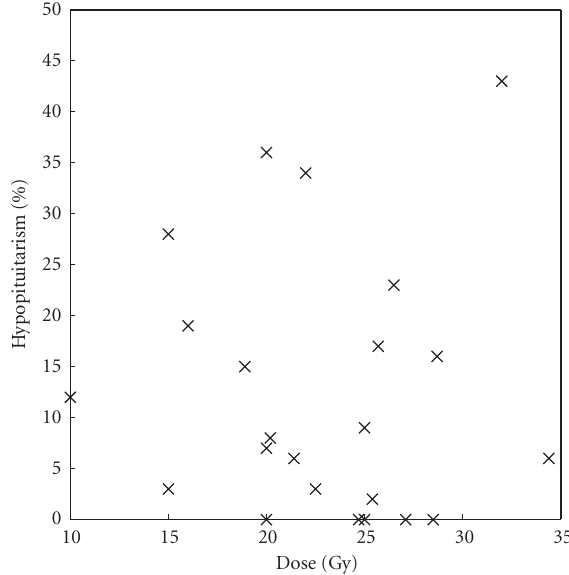
Figure 2: E ff ect of GKS dose on hypopituitarism as an adverse event. The rate of hypopituitarism is shown as a function of GKS dose for each study. There is no definite relationship. Again, however, the heterogeneity in study design, follow-up, and other parameters makes it di ffi cult to draw definitive conclusions from this